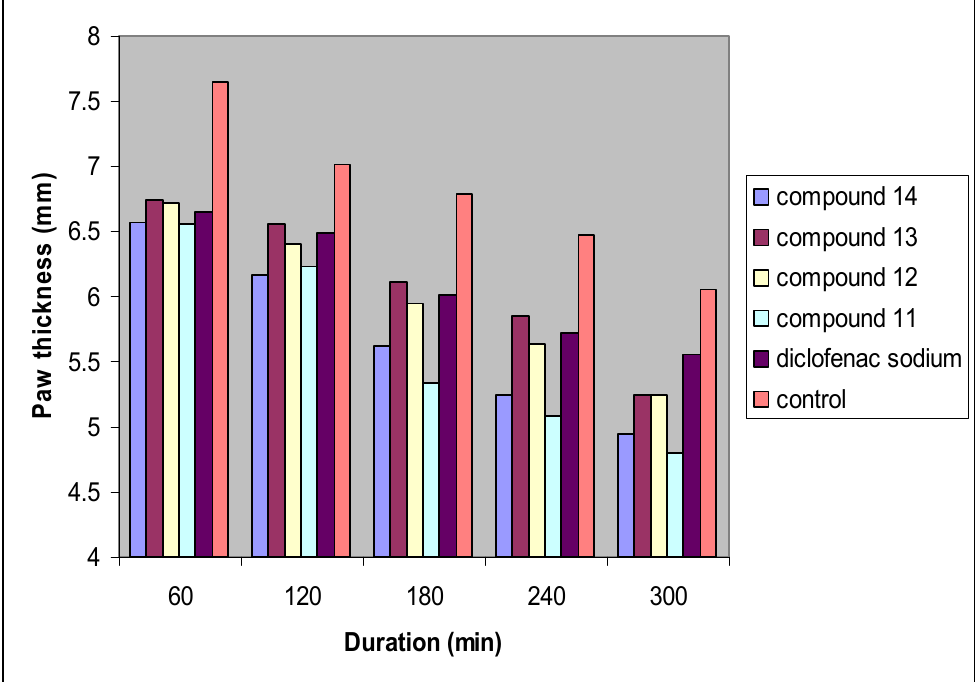
Figure 3. Effect of diclofenac sodium, propylene glycol, compounds 11, 12, 13 and 14 on egg-white induced paw edema in rats. Results are expressed as mean ± SEM (n = 6 for each group). Time (30) is the time of egg-white